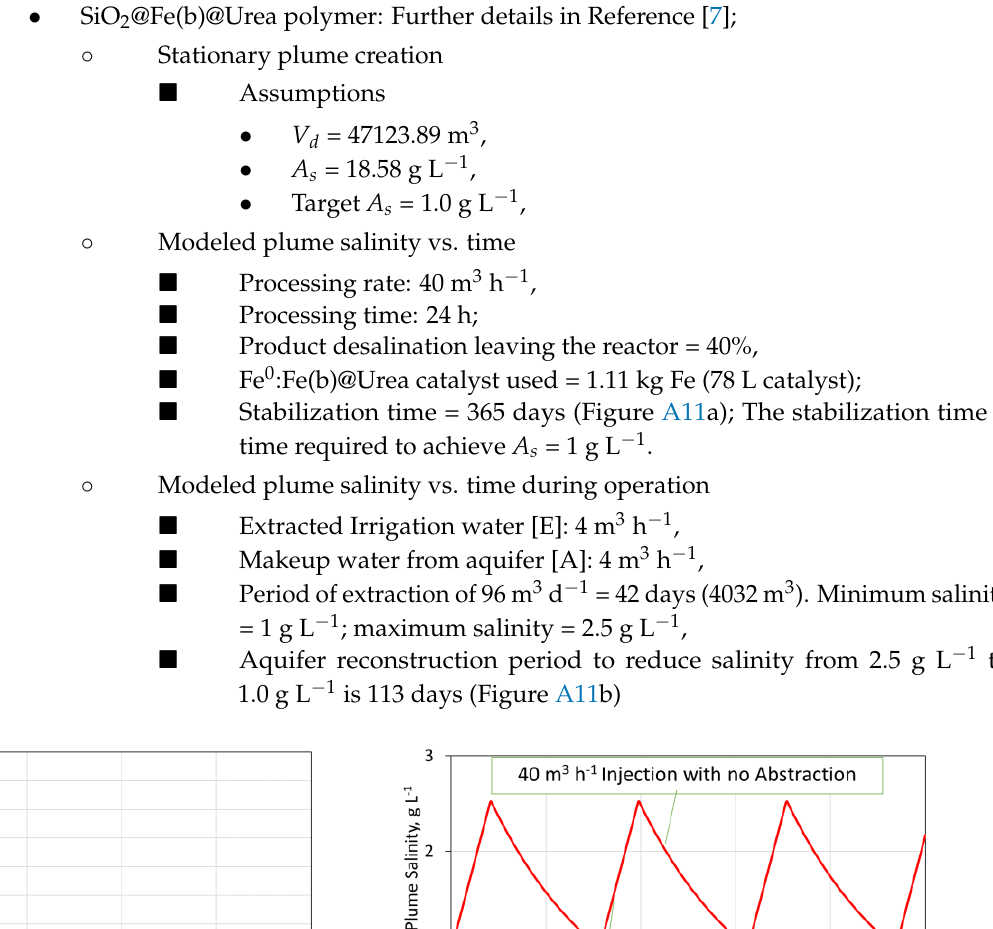
Figure A10. Modeled stationary plume. Fe 0 :Fe(b)@Urea polymer catalyst: time required to reduce the plume salinity.